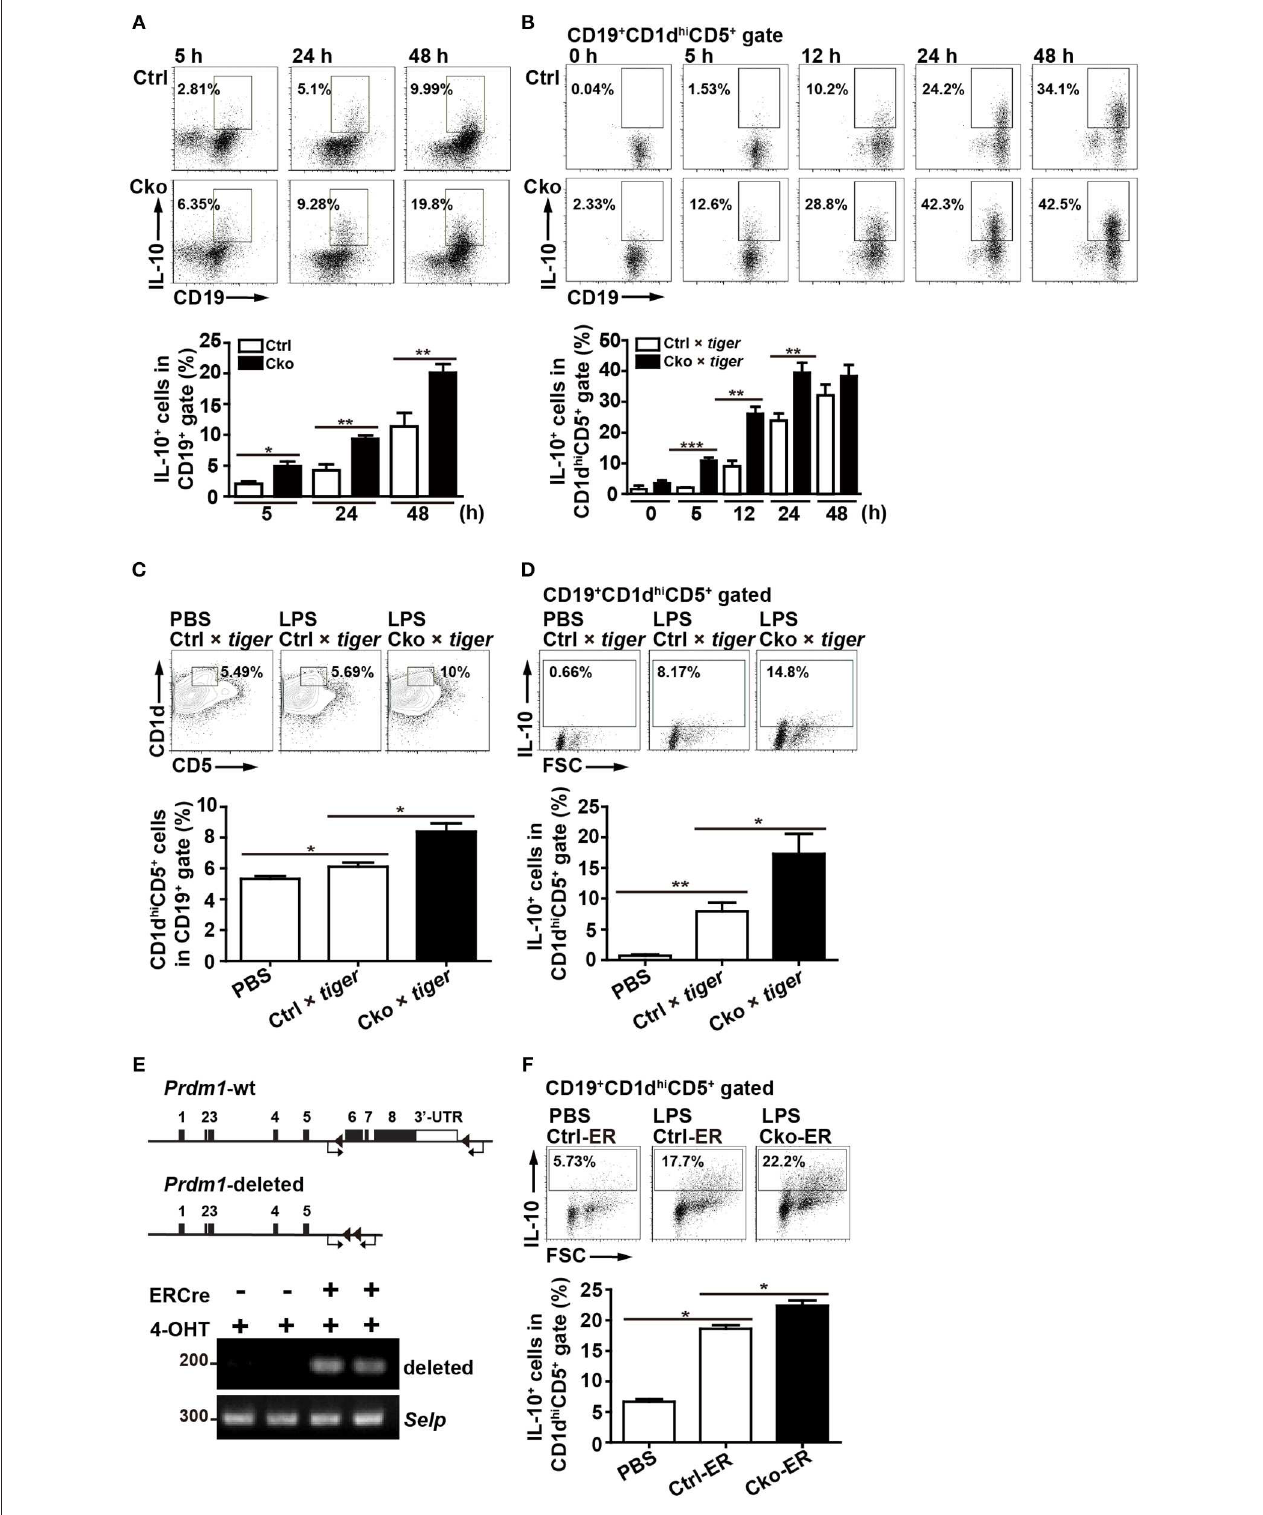
FIGURE 2 | Splenic B10 population in Ctrl and Cko mice. (A) Splenic B cells were purified from Prdm1 f / f CD19 cre / + mice (Cko) or control littermates ( Prdm1 f / f CD19 + / + , Ctrl) and then stimulated with LPS (10 µ g/ml) for 5–48h. PMA, ionomycin, and monensin (PIM) were added into culture for the final 5h for